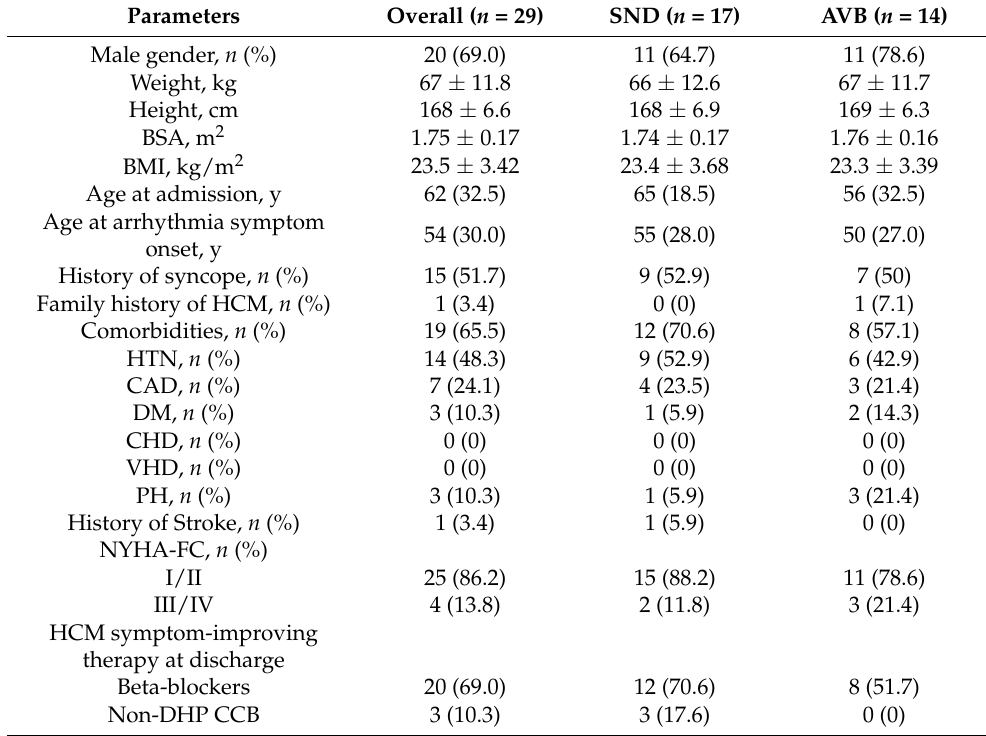
Table 1. Demographic and clinical characteristics.